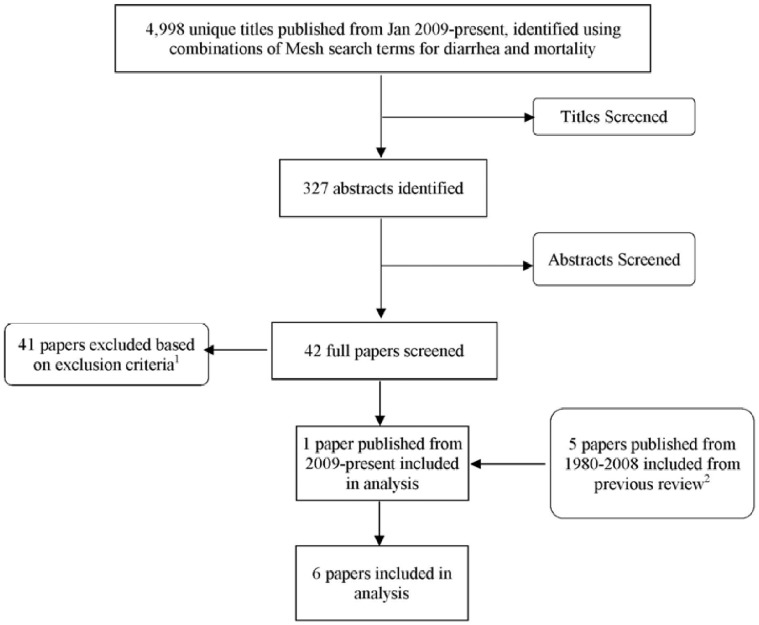
Results of the systematic review.Footnotes: 1Main reasons for exclusion: no outcome of interest (n = 23); review paper (n = 5); under-five data only (n = 5); data combined across under-five and older age groups (n = 4); retrospective review of hospital records (n = 3); special population (n = 1). 2 Source: Fischer Walker CL, Black RE (2010) Diarrhoea morbidity and mortality in older children, adolescents, and adults. Epidemiol Infect 138: 1215–1226.